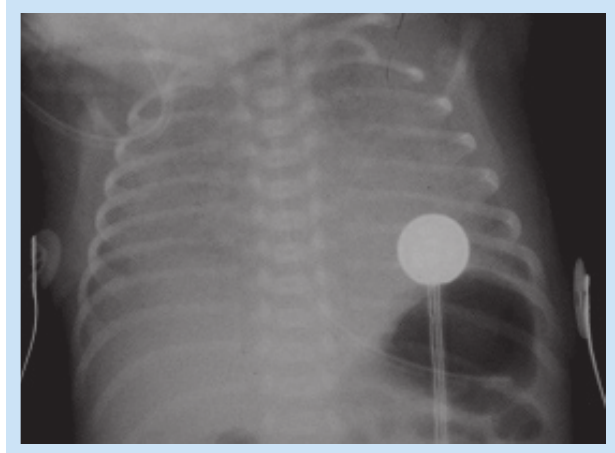
Fig. 4. Identification of the variety of lines and tubes. • There is a left-sided intercostal drain with the side holes located within